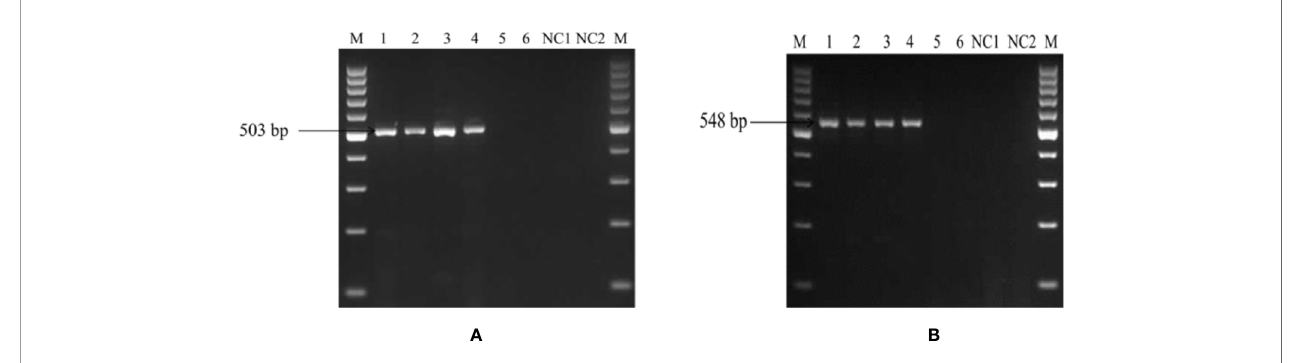
FIGURE 5 | Polymerase chain reaction (PCR) based sensitivity test of the UA-17F/UA-519R (A) and UA-15F/UA-562R (B) marker with different amounts of DNA template of U. agropyri FLS1 teliospore suspension (4.2 × 10 4 to 4.2 × 10 − 1 spores g − 1 soil) mixed with sterile soil. M: Marker; Lanes 1 – 6 indicate serial dilutions (1:10) of the fungal spores ’ suspension ( i.e. Lane 1: 42,000 spores g − 1 soil, Lane 2: 4,200 spores g − 1 soil, Lane 3: 420 spores g − 1 soil, Lane 4: 42 spores g − 1 soil,